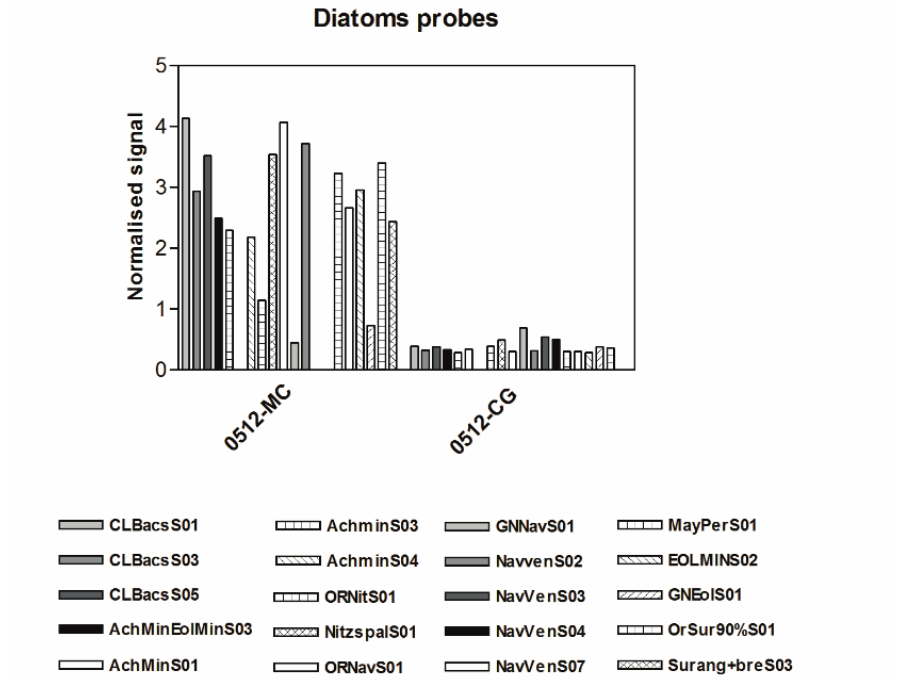
Figure 5. Diatom probes from the Mezzocammino and Castel Giubileo samples. Signal intensities of each probe were normalized with Dunaliella RNA 12.5 µM probe signal. Pseudomonas , Bacillus , Listeria Escherichia and Salmonella. at the genus level and Staphylococcus aureus were detected at both sites, with low signal intensities in the Castel Giubileo